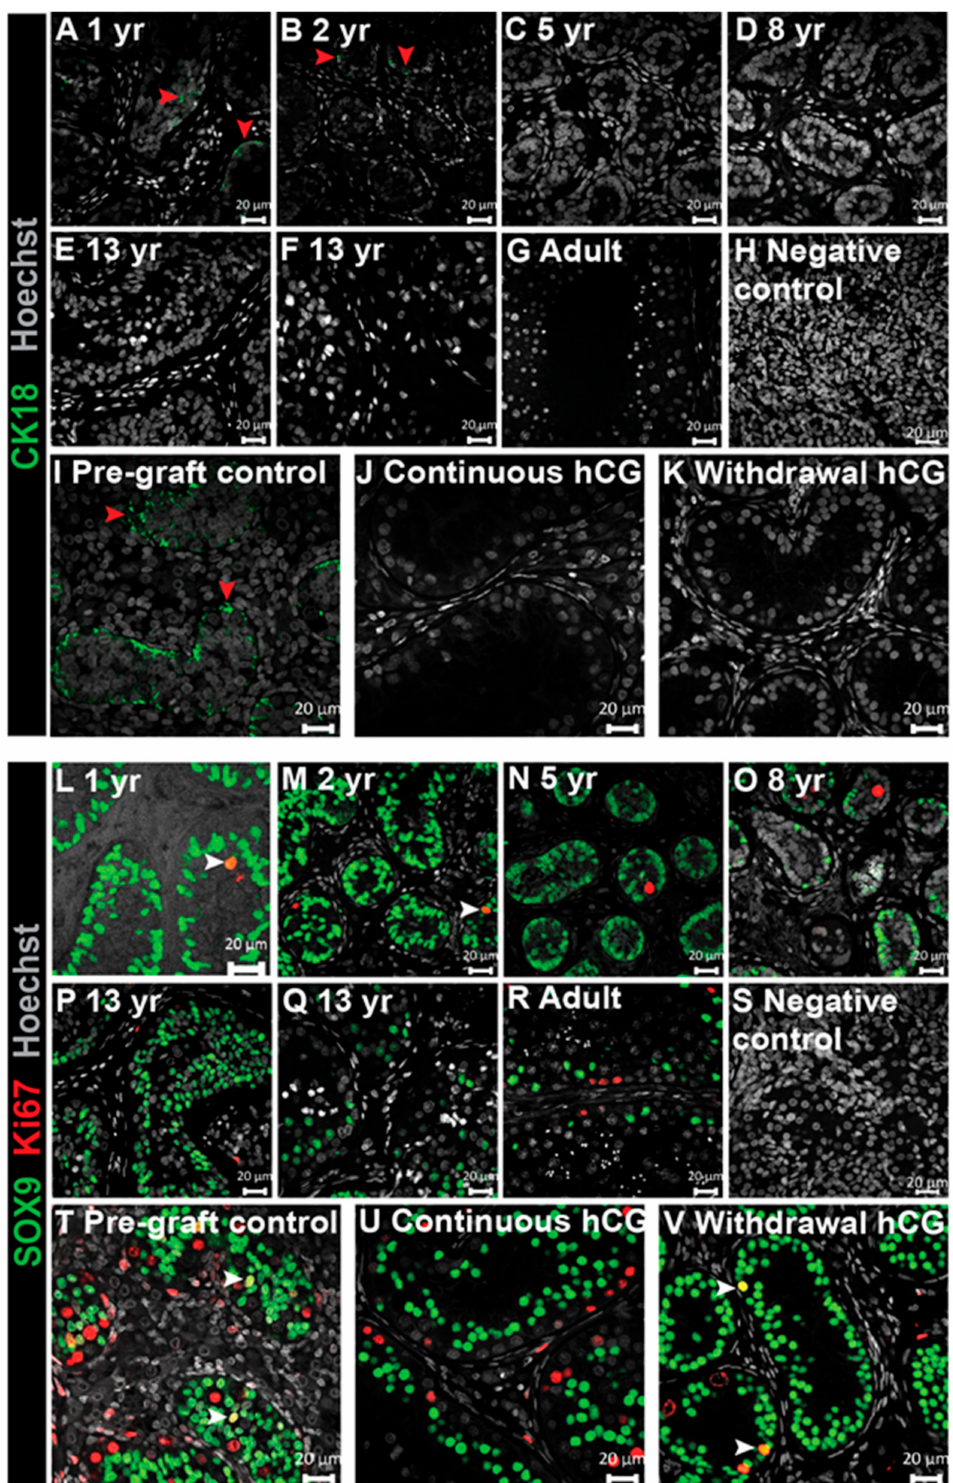
Figure 4. Downregulation of immature Sertoli cell features in long-term continuously hCG-exposed human fetal testis xenografts. ( A – G ) The characterisation of CK18 (Sertoli cell marker) expression across human testis development. ( H ) The negative control (second-trimester human fetal testis). ( I – K ) Immunopositive staining for CK18 was found in all pre-graft control testis tissues (17 GW) but not in long-term xenografts exposed continuously to hCG (12 months hCG) or ‘Withdrawal hCG’ grafts (7 months hCG followed by 5 months withdrawal hCG). The images in ( J , K ) are representative of n = 27 and n = 4, respectively. The red arrowheads denote CK18 + cells. ( L – R ) The characterisation of